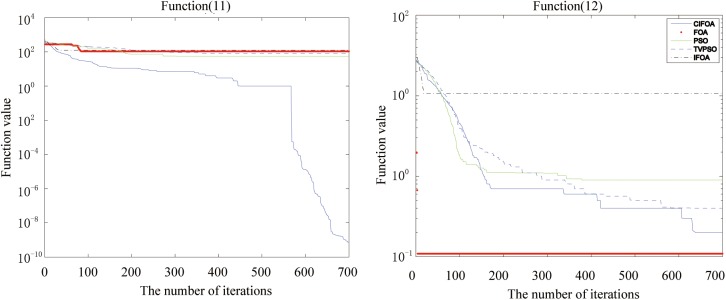
The fitness value of various algorithms for Rastrigin and the Solomon problem during increasing iterative times.